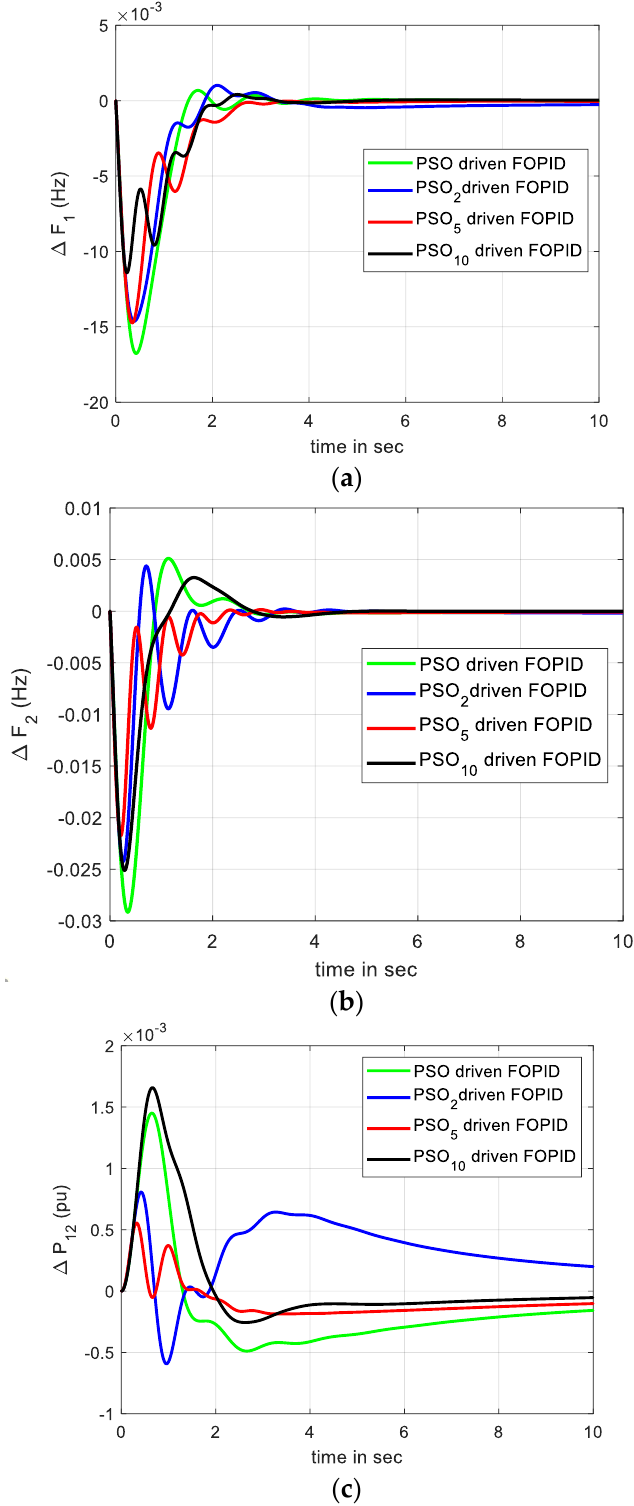
Figure 7. Dynamic response for the frequency deviation and tie-line power flow for case study-I: ( a ) Δ𝐹 Δ𝐹 Δ𝑃 1 , ( b ) 2 , and ( c ) 12 .